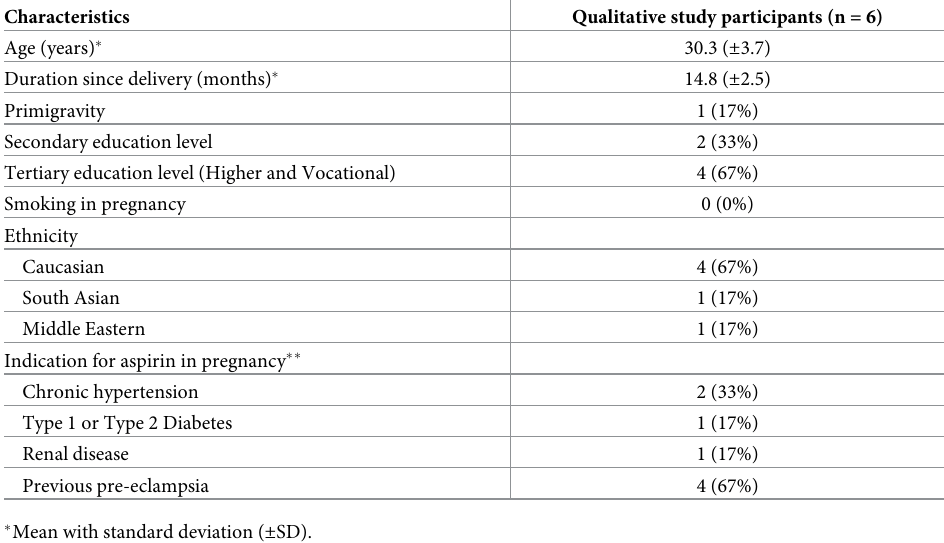
Table 2. Characteristics of participants in qualitative study.